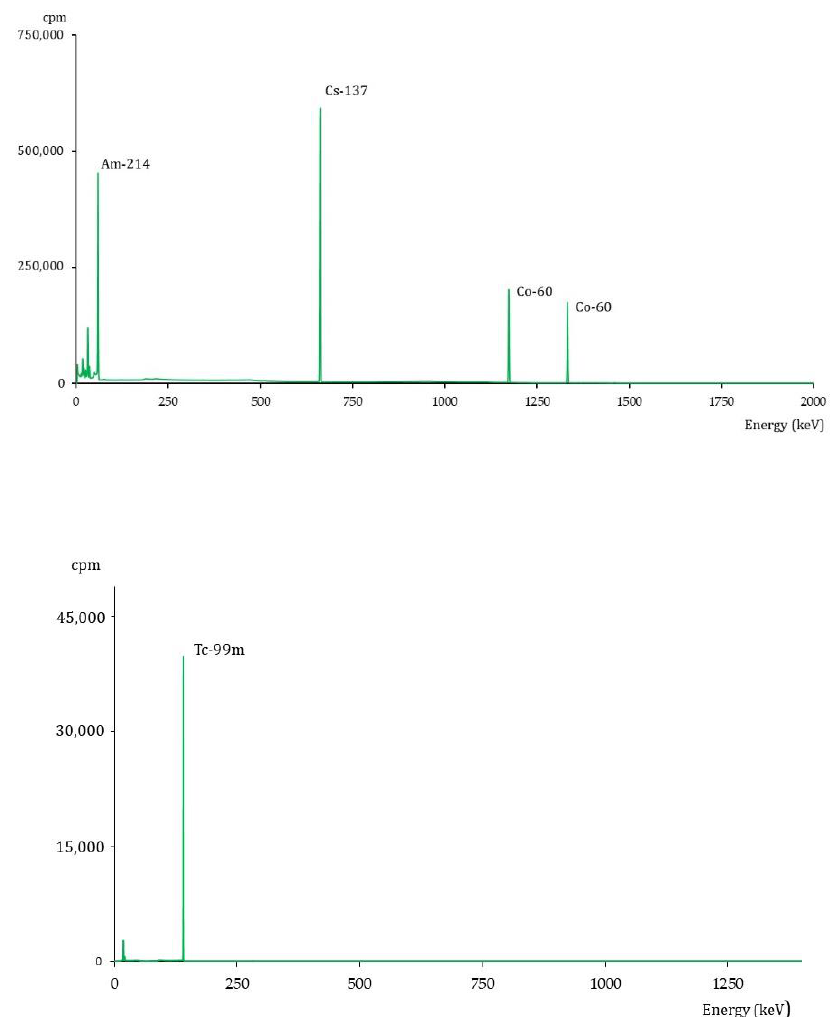
Figure 1. Gamma ray spectrum of the working solution containing Am-241, Cs-137 and Co-60 ( upper ) or Tc-99m ( bottom ).